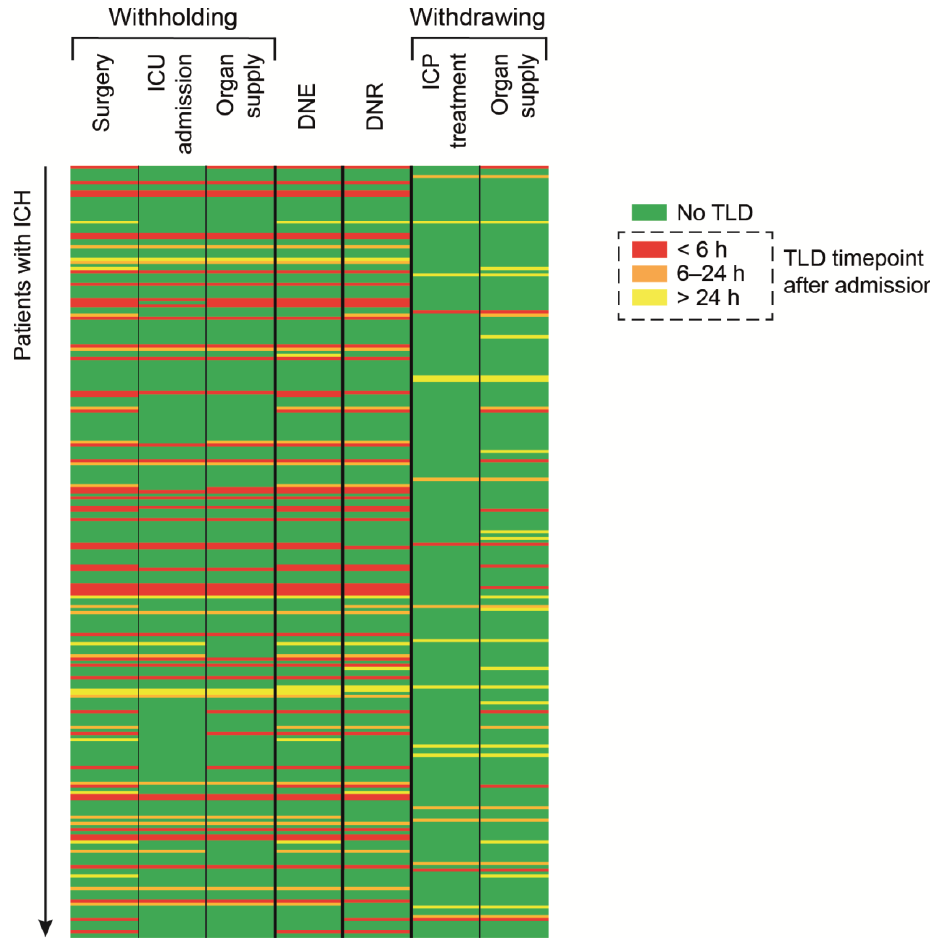
Figure 1. Illustrated synopsis of the TLD-making process, including its time-related context. ICH, intracerebral hemorrhage, ICU, intensive care unit, DNE, do-not-escalate, DNR, do-not-resuscitate, ICP, intracranial pressure, TLD, treatment-limiting decisions. Table 2. Characteristics of TLDs in patients with ICH. TLD Patients with ICH ( n = 249) withholding surgery 79